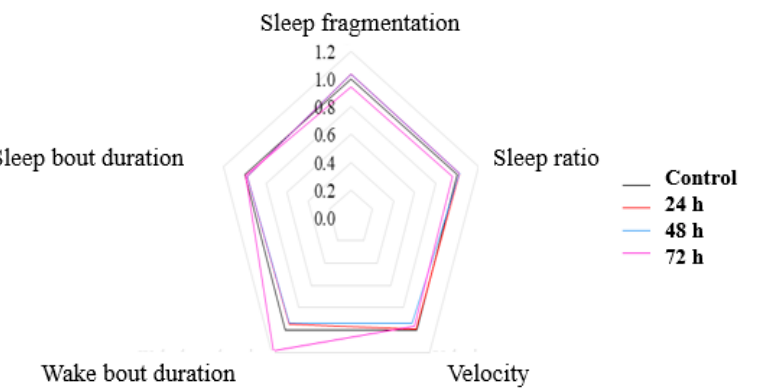
Figure 6. A pentagon depicting the changes in sleep parameters following VPA administration. All parameters are depicted as ratios of Group 1 (set as 1). Group 1, control; Group 2, group exposed for 24 h to VPA; Group 3, group exposed for 48 h to VPA; and Group 4, group exposed for 72 h to VPA.